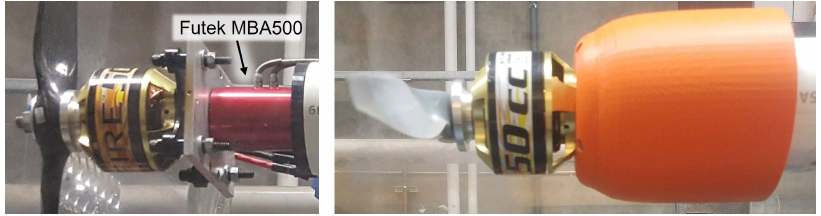
Figure 8. Dynamometer load cell arrangement ( left ) with cowling ( right